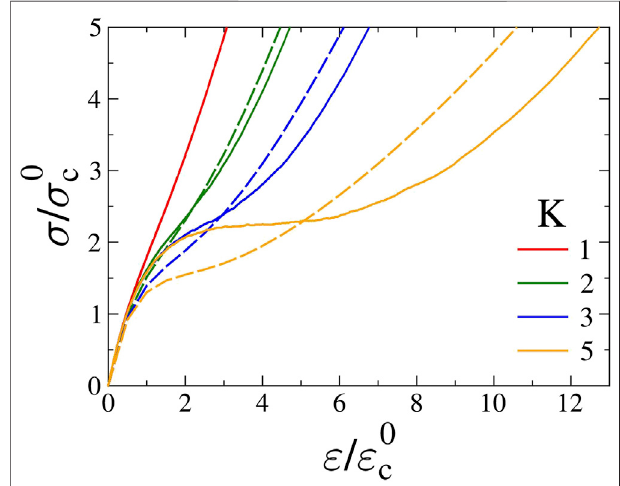
FIGURE9| Comparisonoftheconstitutivecurvesofhardeningstick-slip bundles with quenched ( dashed lines ) and annealed ( continuous lines ) failure thresholdsforseveralvaluesofthe fi xednumberofallowedslipevents K atthe stiffness parameter a (cid:1) 0 . 8.